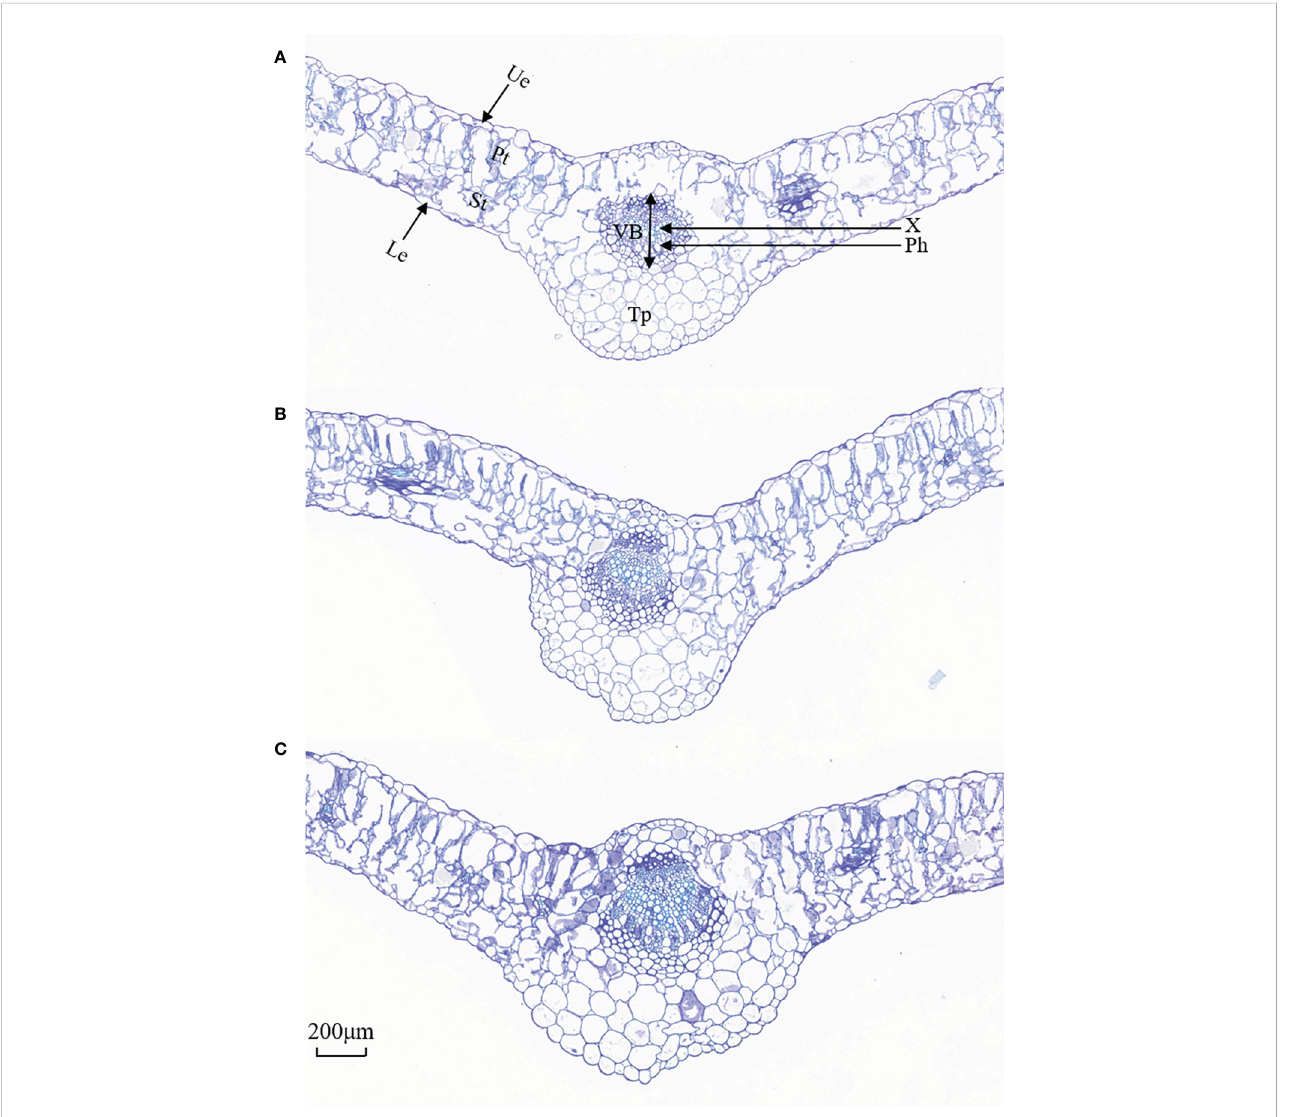
FIGURE 4 Representative images of cross-sectional structure of Lycium barbarum L. leaves (10×). (A) CK (0 mmol·L − 1 ). (B) 100 mmol·L − 1 . (C) 200 mmol·L − 1 . Ue, upper epidermal; Le, lower epidermis; Pt, palisade tissue; St, spongy tissue; VB, vascular bundle; X, xylem; Ph, phloem; Tp, thick parenchyma (thick angles and